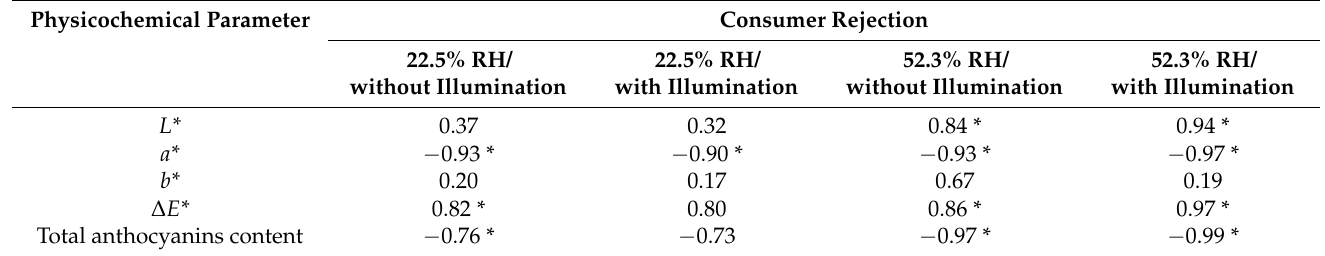
Table 5. Correlation coefficients ( r ) between the consumer rejection probability and physicochemical properties of strawberry leather during